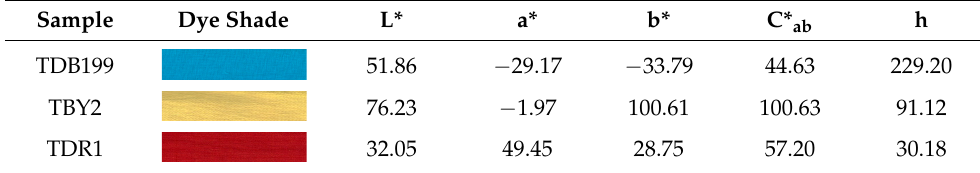
Table 3. Values L*, a*, b*, C* ab y h of each dyeing. Table 3. ValuesL *, a *, b *, C * ab y h of each dyeing. Table 3. ValuesL *, a *, b *, C * ab y h of each dyeing. Table 3. ValuesL *, a *, b *, C * ab y h of each dyeing.